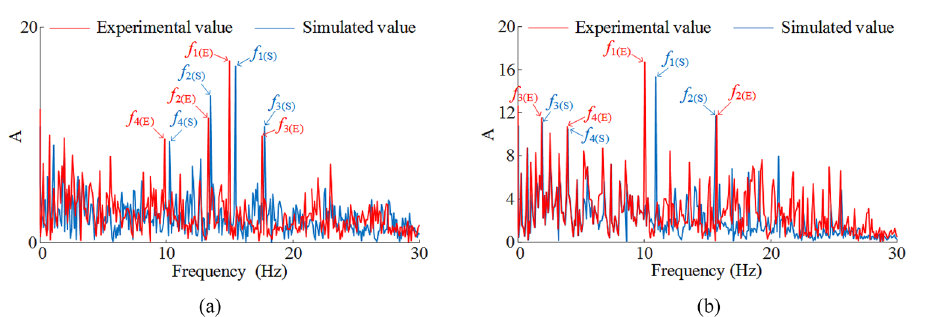
Figure 15. Vibration frequency spectrum: ( a ) ranging arm, ( b ) walking unit.